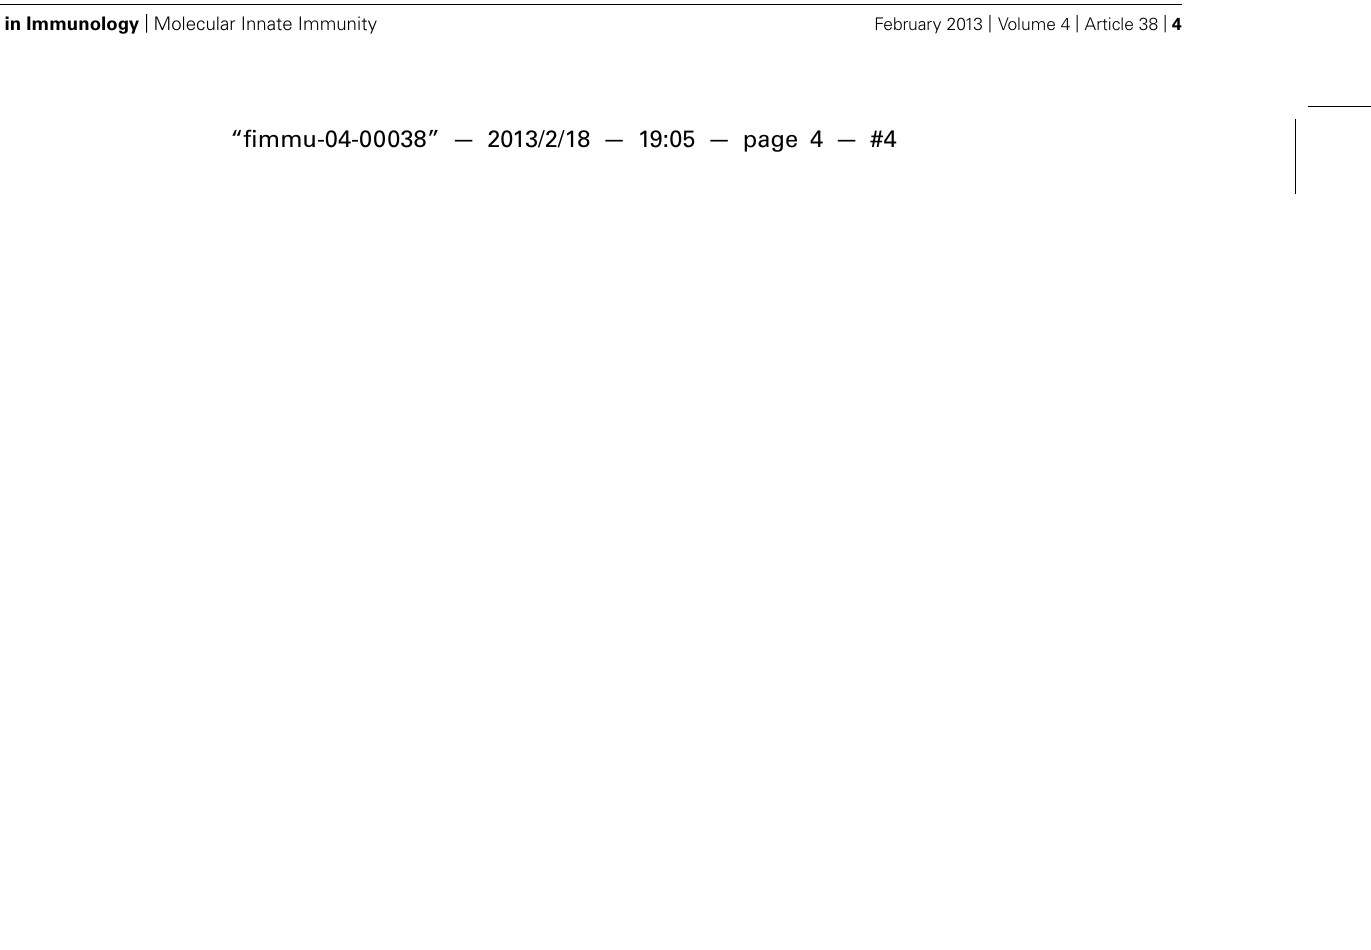
A23187 ionophore (Io) or ionomycin (Im), and/or PMA for 2 h. Cells were lysed and analyzed by western blotting to detect deiminated histone H3 (dH3) vs. total H3 (tH3).The presence of stimuli is indicated by a plus sign.